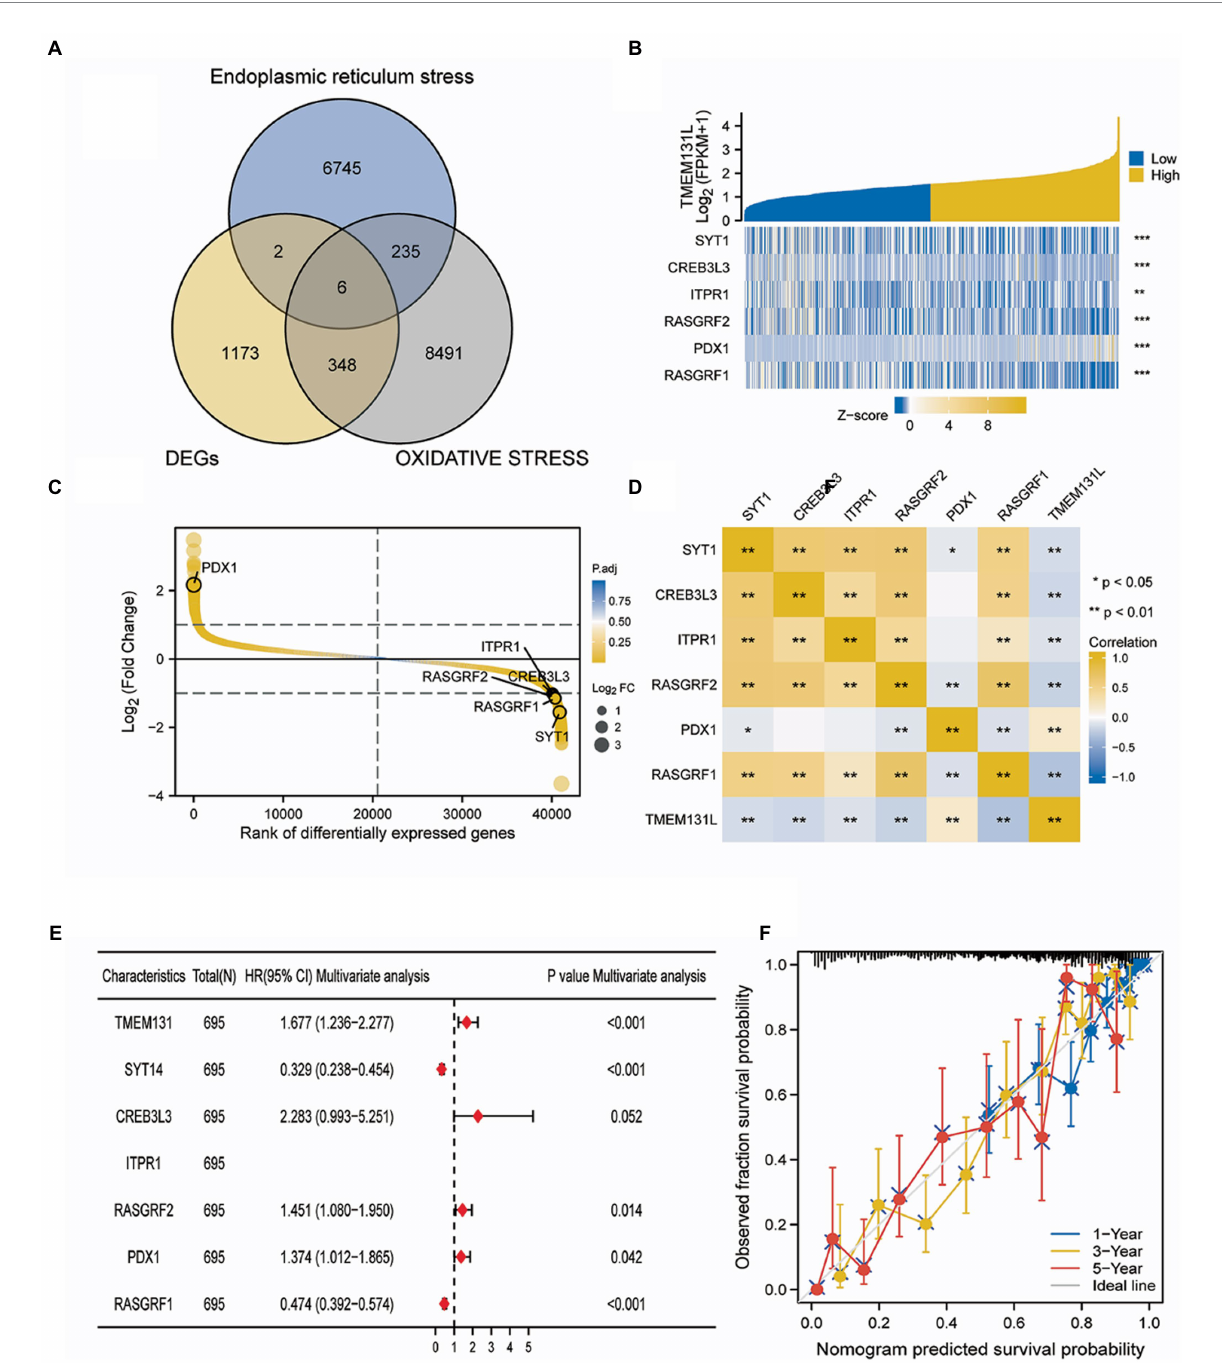
FIGURE 11 Screening of oxidative stress co-expression genes of TMEM131L. (A) Venn diagram of intersection of oxidative stress and endoplasmic reticulum stress phenotypic related genes and TMEM131L co-expressed genes; (B) The heat map of the Hub gene expression differences between groups of TMEM131L with high and low expression; (C,D) Hub genes and TMEM131L co-expressed in a manner that was depicted by a heat map and differential sequencing map; (E) Nomogram of Hub genes for predicting 1-, 3-, and 5-year survival in GBMLGG patients; (F) To demonstrate the discrepancy between nomogram prediction and actual survival of Hub genes, calibration curves are used to assess nomogram-predicted 1-, 3-, and 5-year